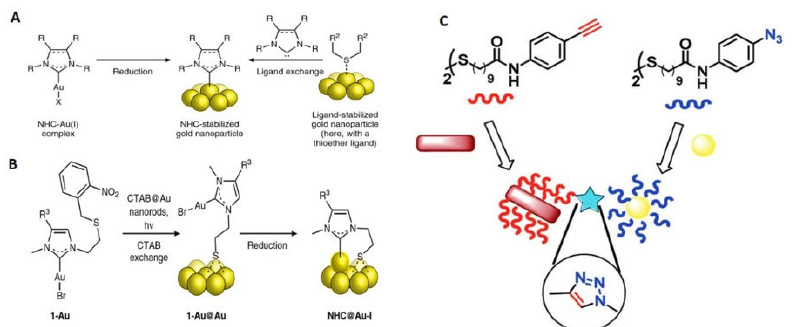
Figure 6. Strategies for NHCs being based on gold nanomaterials ( A ) Previous methods involve the reduction of preformed or in situ generated (the latter from imidazolium tetrahaloaurate salts) NHC–metal (for example, gold) complexes, or the displacement of weakly bound (for example, thioether or amine) ligands with free NHCs. X, a coordinating ligand, typically a halogen such as Cl or Br; R and R2, alkyl, aryl or other substituents. ( B ) Here, we introduce a bidentate thiolate masked NHC strategy whereby exchange of CTAB ligands on commercial CTAB@Au nanorods with a photogenerated thiolate is followed by NHC installation ( C ) new surface-bound NHC–gold adatom complex [44]. Reprinted with permission from ref. [44]. Copyright 2018 Nature Chemistry.